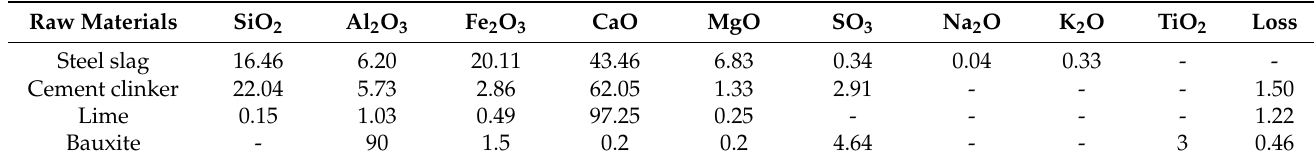
Table 1. Chemical composition of raw materials (wt